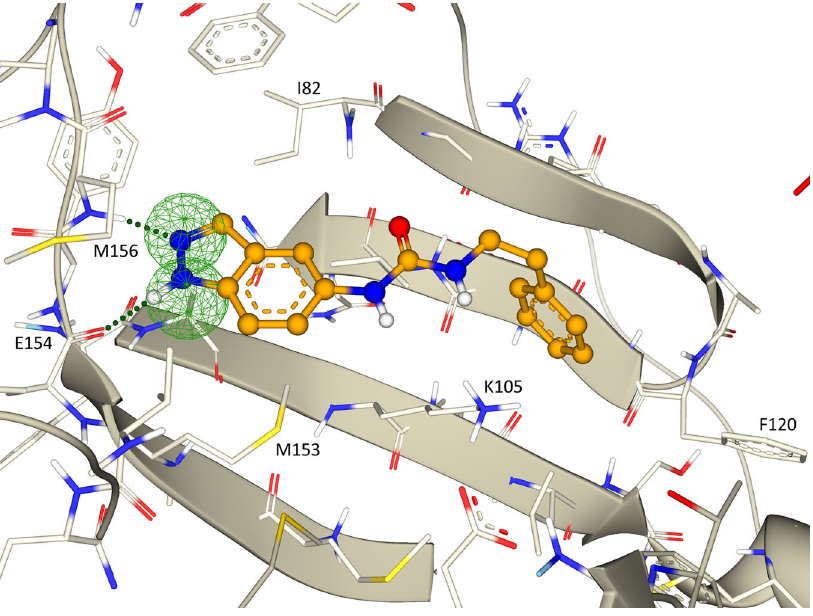
Fig. 7 | The ATP binding site of ROCK1 (PDB ID: 2ETR). The pharmacophore constraintforhydrogenbondinteractionwiththekinasehingeresiduesisshownas